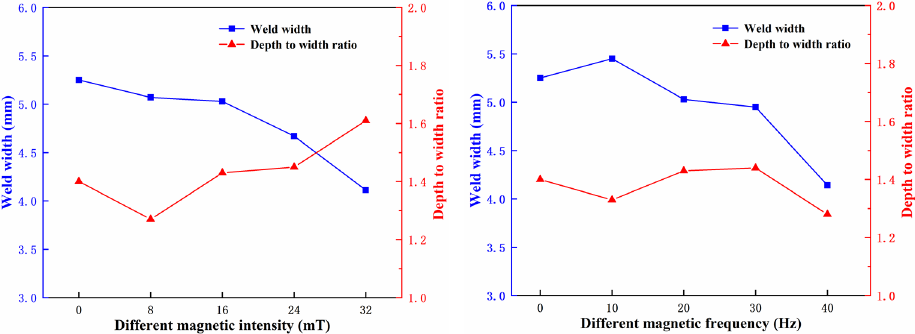
Figure 14. Weld width and depth to width ratio under different magnetic intensity and frequency.